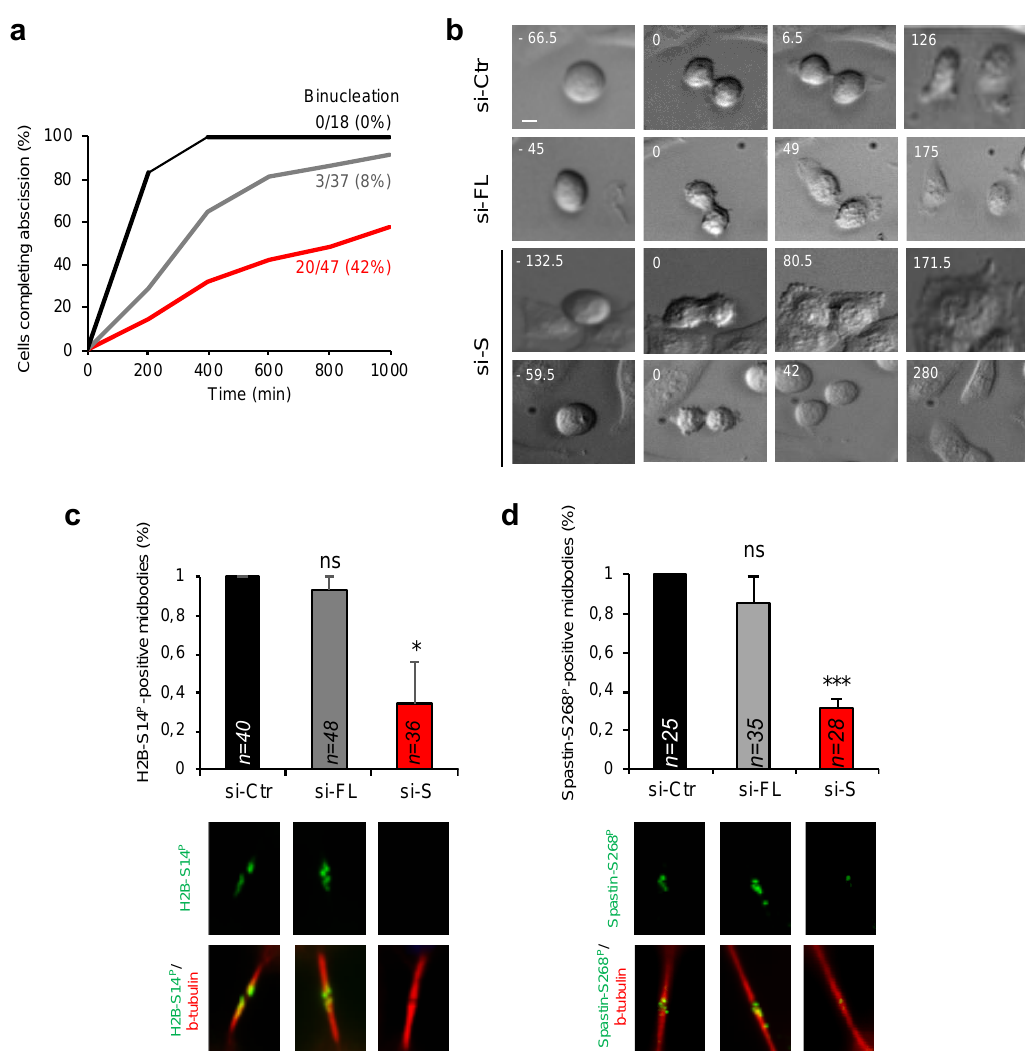
Figure 6. HIPK2-S but not HIPK2-FL is required for successful cytokinesis. ( a ) HeLa cells were transfected as in Figure 5b and analyzed by time lapse imaging 70 h post-transfection. The abscission time, i.e., from cleavage furrow ingression to abscission, was determined and the cumulative percentage of the analyzed cells (si-Ctr, n = 18; si-FL, n = 37; si-S, n = 47) from three independent transfections is plotted as a function of time. The percentage of cells that fail cytokinesis and undergo binucleation is also reported. ( b ) Representative stills from time-lapse imaging of cells recorded in ( a ). The time from the beginning of the round-up is shown in h:min. Scale bar is 10 μm. The relative videos are Videos S1‒S4. ( c , d ) HeLa cells were transfected as in ( a ) and analyzed 96 h post-transfection by IF after staining with anti-phospho-H2B-S14 or anti-phospho-spastin-S268 Abs in combination with anti- β -tubulin to mark midbody. Data are reported as mean ± SD of three independent experiments * p < 0.05; *** p < 0.0001. Representative images of midbody magnification are reported below each column, while the numbers of analyzed midbodies are reported inside the relative columns.